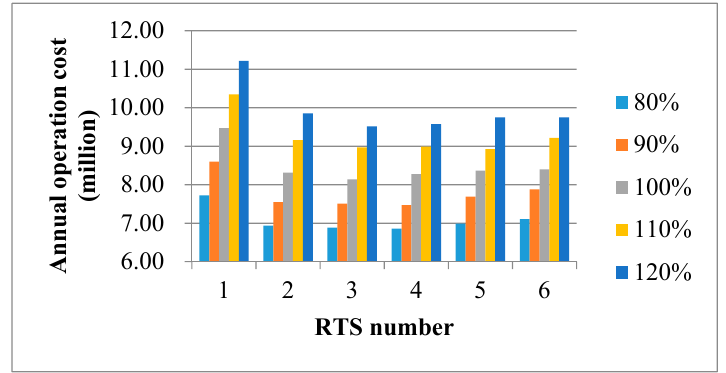
Figure 5. Sensitivity analysis of the unit transportation cost. RTS: refuse transfer stations.